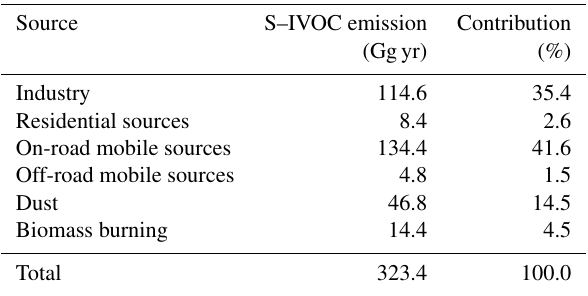
Table 3. S–IVOC emission inventory in the PRD region for the year 2010. Source S–IVOC emission Contribution (Ggyr) (%) Industry 114.6 35.4 Residential sources 8.4 2.6 On-road mobile sources 134.4 41.6 Off-road mobile sources